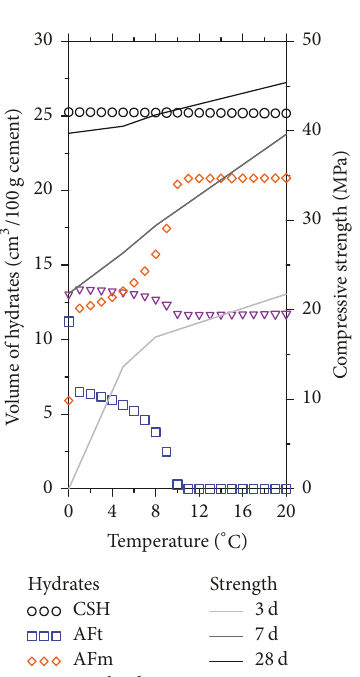
Figure 10: Relationships between strength, hydrates, and tempera-